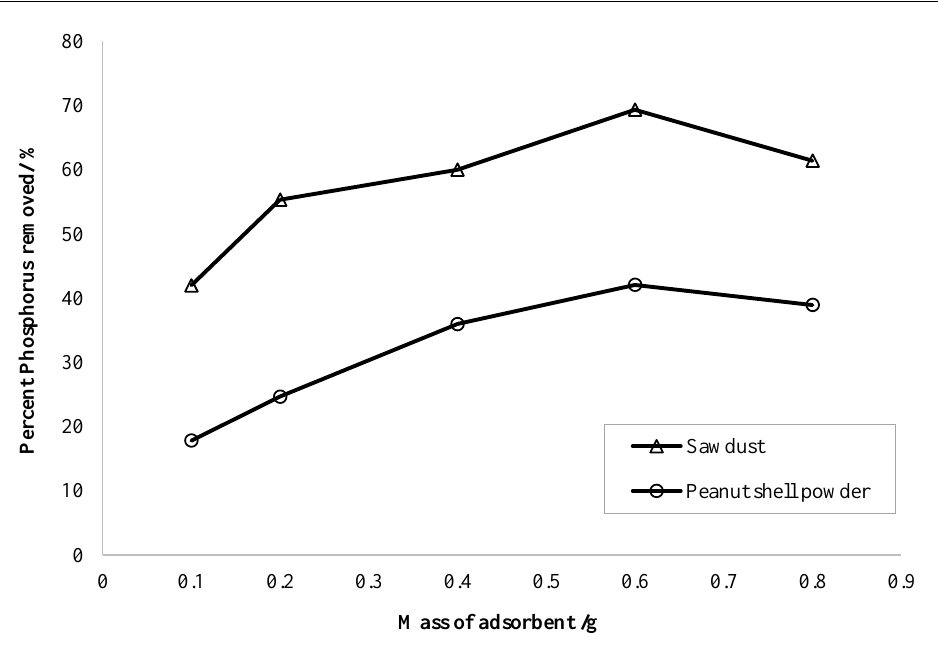
Figure 1. Effect of mass of adsorbent on phosphorus